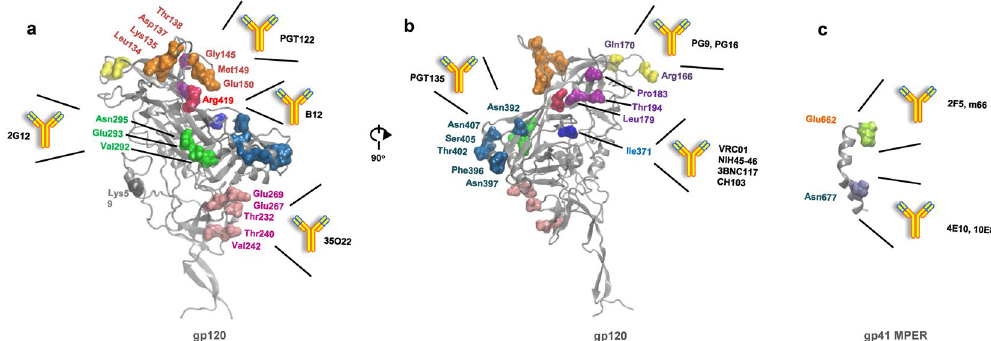
Figure 3. Mapping of treatment failure-related mutations on the high-resolution structures of HIV-1 gp120 ( a ) and 90° views ( b ) and gp41 MPER ( c ). Most treatment failure-related mutations overlapped with the neutralization epitopes of different kinds of bnAbs.